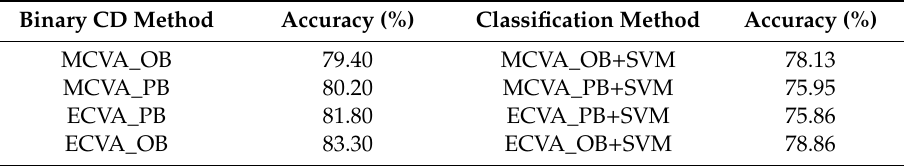
Table 6. Comparison of the accuracy of the di ff erent